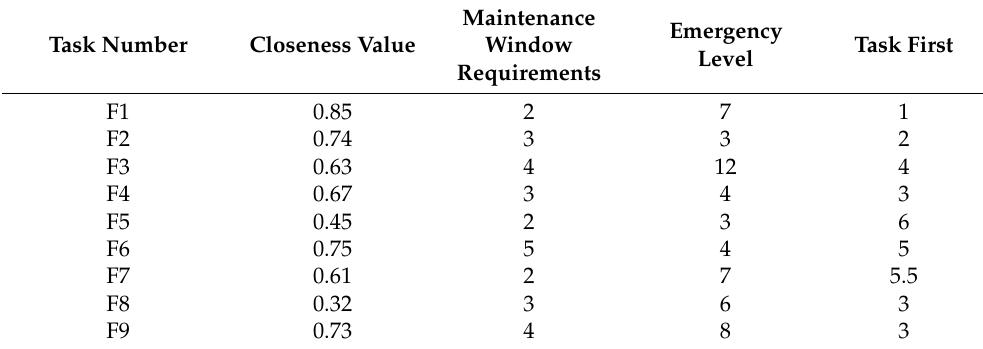
Table 6. Task information and combined task closeness value.